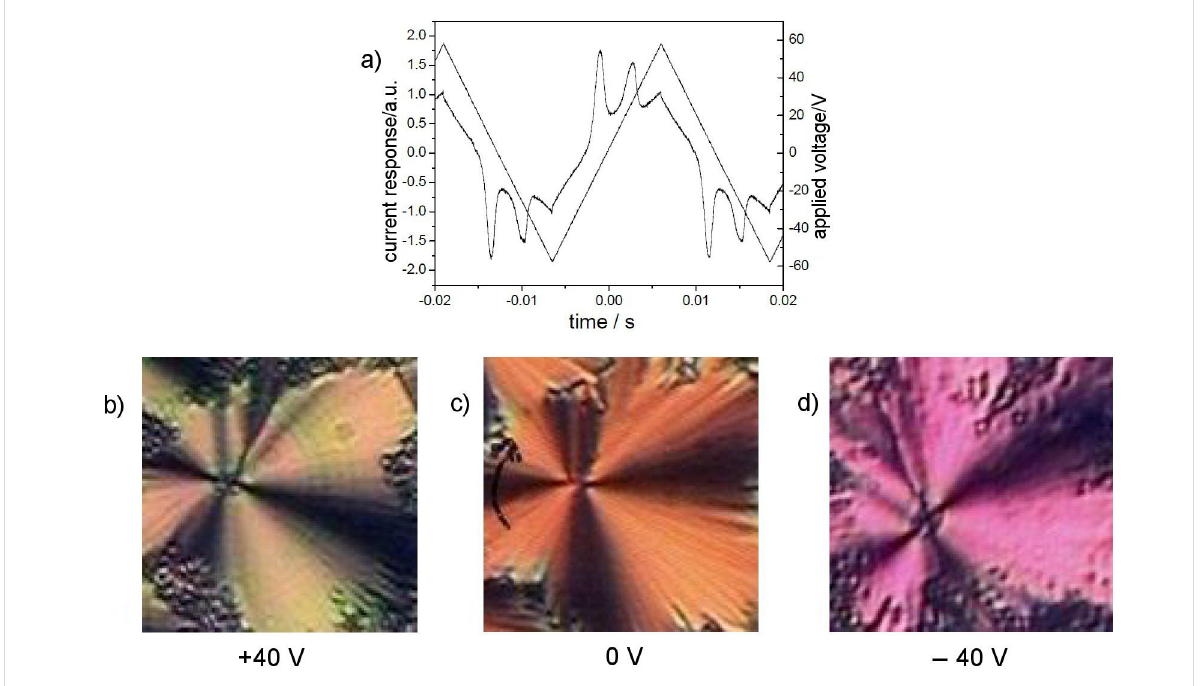
Figure 15: Switching behaviour of compound OH 4b at 120 °C: a) Current response curve ( U = 116 V pp , f = 40 Hz, T = 120 °C, d cell = 6 μ m, P S = 600 nC/cm 2 ); b) tristable switching observed on circular domains applying a D.C. voltage ( U = ± 40 V, T = 122 °C, d cell = 6 μ m).